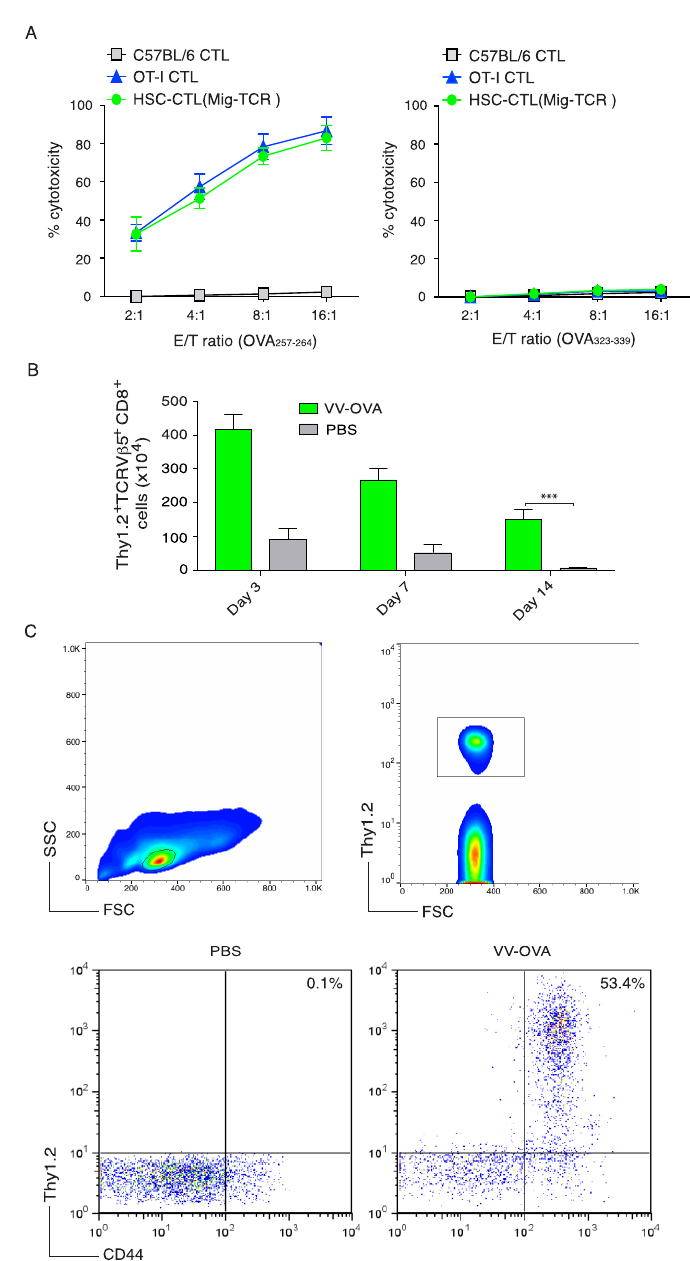
Figure 3. Ag-specific HSC-CTLs persist in vivo. After the development of Ag-specific CD8 + T cells by genetic modification of HSCs a in vivo priming as described in Figure 2, CD8 + Thy1.2 + TCRVβ5 + T cells from the pooled LNs and spleen were sorted and an in vitro cytotoxicity assay was performed. In some experiments, mice were infected i.p. with VV-OVA or PBS. After various days, OVA-specific T cells from the pooled LNs and spleen were analyzed. Five mice were used for each time point. ( A ) In vitro cytotoxicity assay. The HSC-CTLs, OVA 257–264 -specific CTLs from OT-I TCR Tg mice or non-specific CTLs from C57BL/6 mice were added at different effector to target cell (E:T) ratios. Analysis was performed after a 12 h incubation period. Data are shown as mean ± sd from three wells and are representative of three experiments. ( B ) On days 3, 14 and 21, Thy1.2 + TCRVβ5 + CD8 + T cells were counted from the pooled LNs and spleen. Data are the mean number of Thy1.2 + TCRVβ5 + CD8 + cells ± sd from five individual mice and are representative of three experiments (* p < 0.05, Student’s unpaired t -test). ( C ) At day 32, the percentage of Thy1.2 + CD44 + T cells was analyzed by flow cytometry, after gating on live CD8 + T cells in the spleen (upper panels). Results are representative of three experiments.